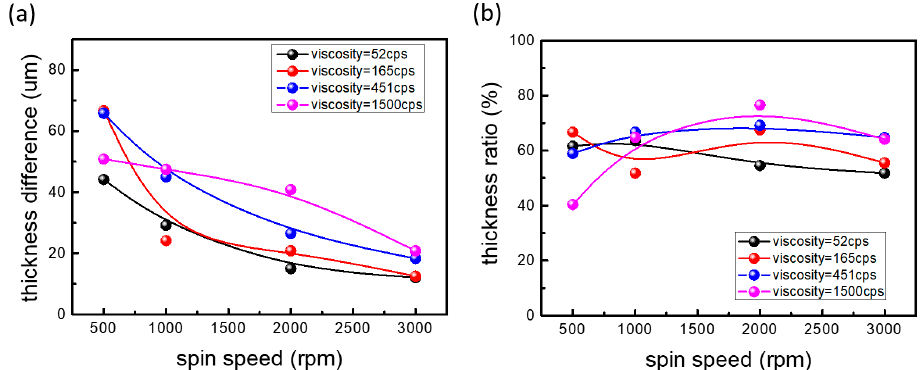
Figure 3. ( a ) Thickness di ff erence and ( b ) thickness ratio in silver-nanowire-embedded flexible electrodes in di ff erent SU8. The thickness di ff erence was calculated by subtracting the thickness at the edge from that at the center. The thickness ratio was obtained by dividing them by the thickness at the edge.